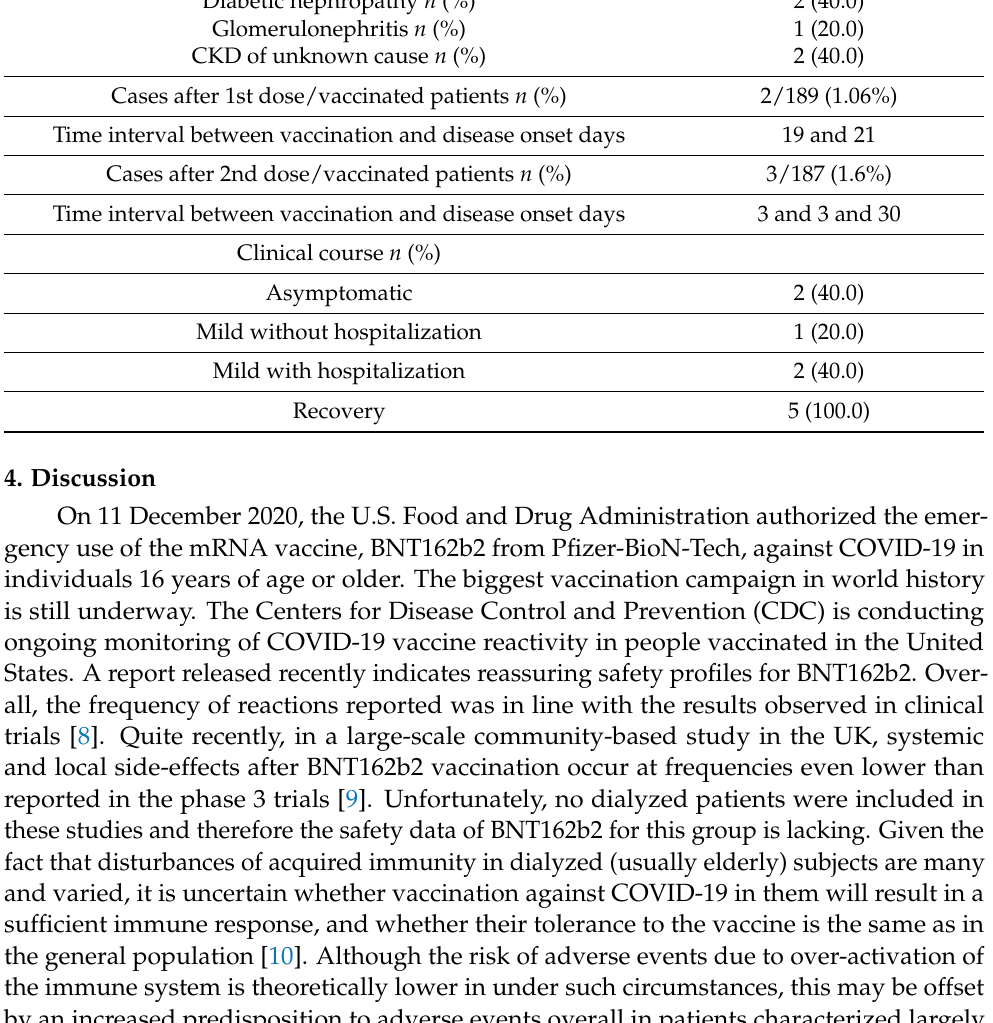
Time interval between vaccination and disease onset